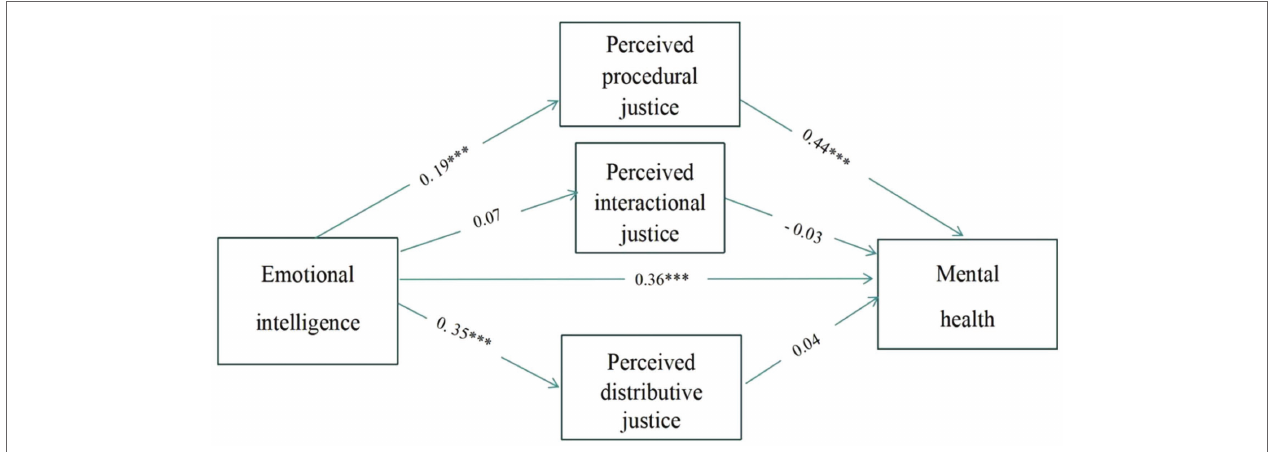
FIGURE 2 | The model of emotional intelligence, different of subtypes of perceived organizational justice and mental